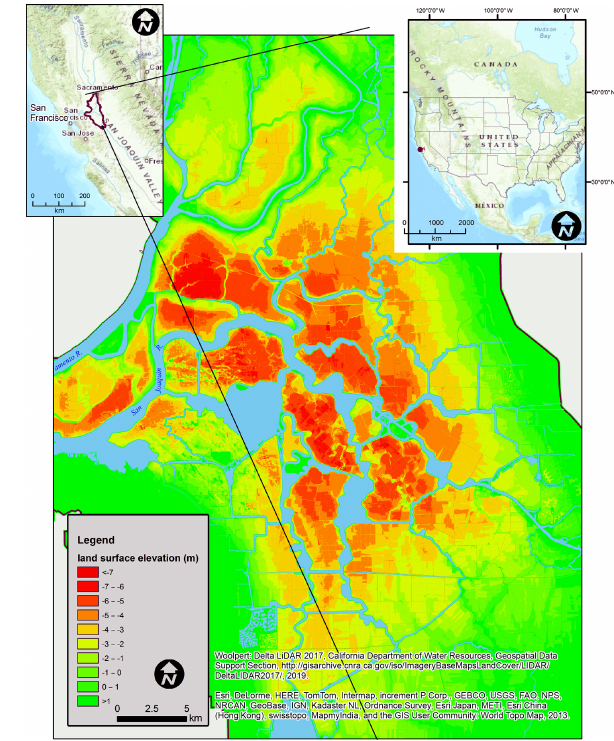
Figure 1. Location of the Sacramento-San Joaquin Delta and 2017